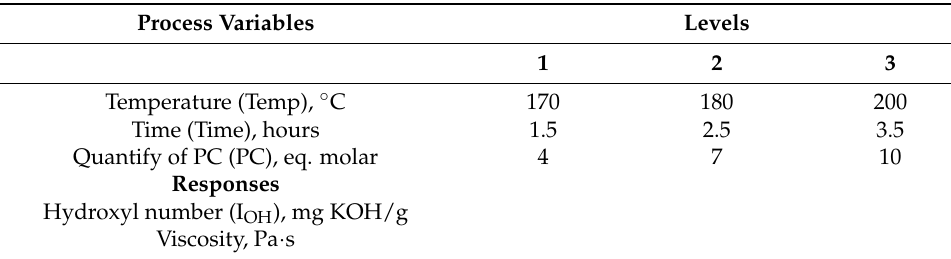
Figure 2. The flowchart of the DoE study. Table 1. Full-factorial design of experiments with three process variables and three levels (3 3 ) for the oxyalkylation of kraft lignin with PC.